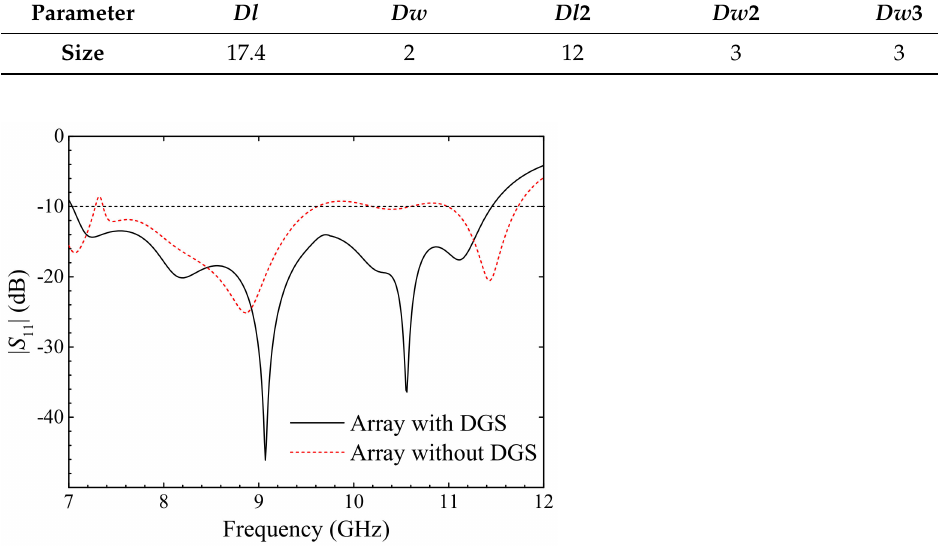
Figure 14. Simulated | S 11 | of the designed antenna array with and without defected ground structure (DGS). Operating bandwidth of the array improved significantly with the DGS.